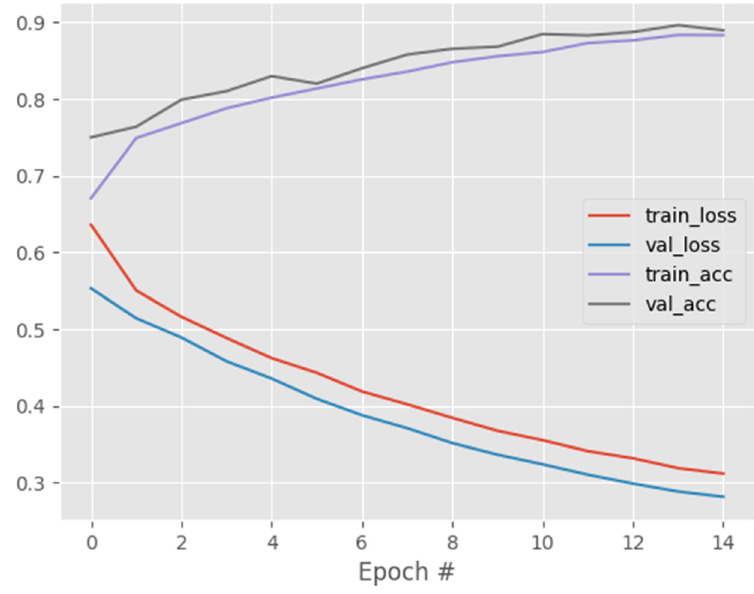
Figure 8. ResNet50 training and validation performance.